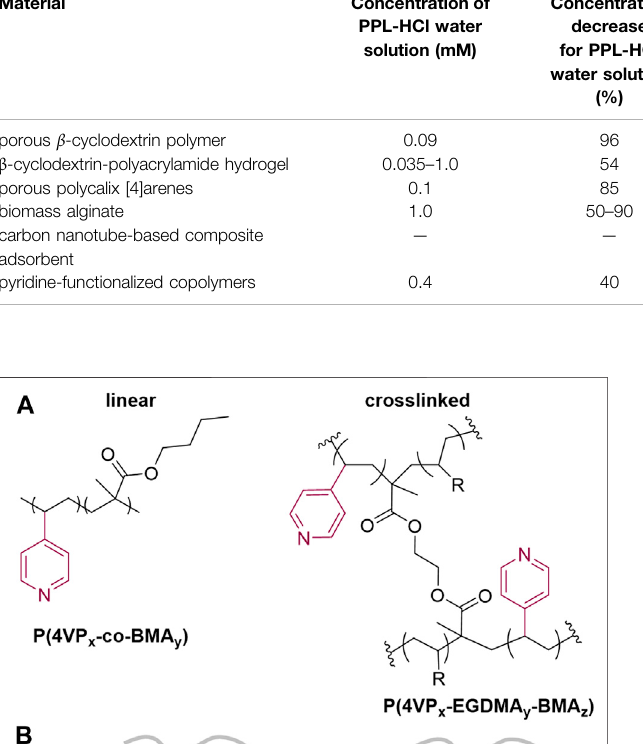
TABLE 1 | The removal performance of reported materials and polymers in this work for PPL-HCl and 2NO . Material